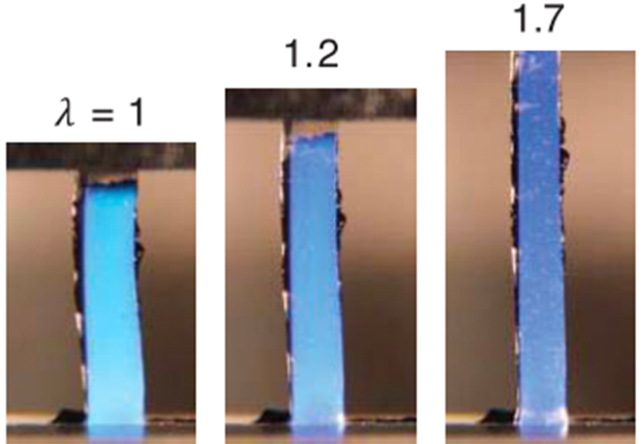
Figure 15. Color alteration from turquoise to dark blue during uniaxial stretching. (Reprinted with permission from Ref. [106] Copyright 2018 AAAS).